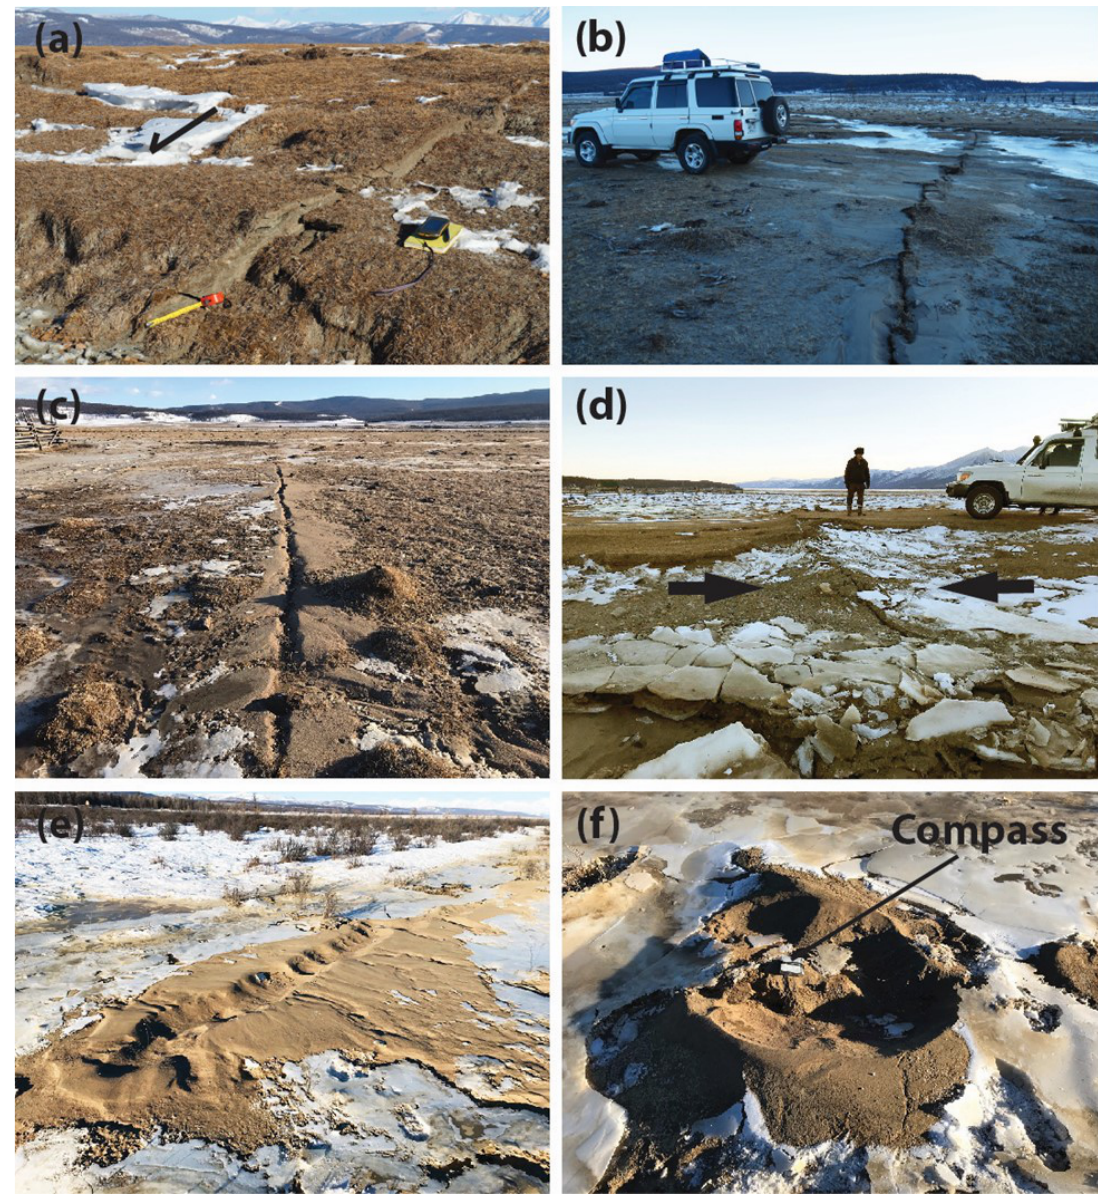
Fig. 5. Micro-features related with the earthquake in the low area between the Doloon Uul peninsula and the Western Range. (a) photo shows a normal fault of ~10 cm with left-lateral strike-slip component of ~5 cm. The western side is up. (b) photograph expresses a right-stepping micro-tension-cracks that implies the left-lateral strike-slip fault. There are the linear cracks with sand liquefaction and sand volcanoes on (c, e, f) photos. Photo (d) shows the small-thrust fault due to local micro-compression. Photos by Battogtokh and